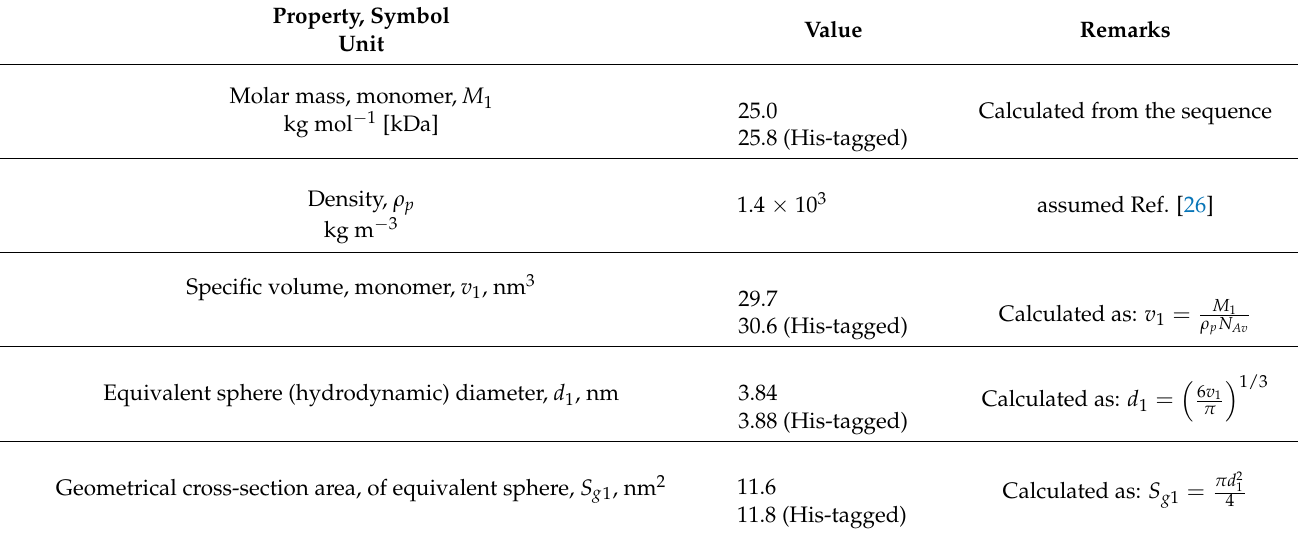
Geometrical cross-section area, of equivalent sphere, S g 1 , nm